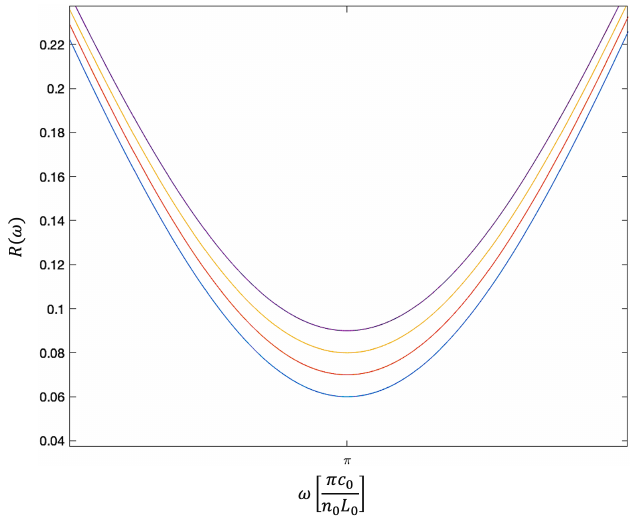
Figure 10. The dependence of the overall reflection rate R ( ω ) in Equation (37) of the Fabry-Pérot cavity in Figure 9 on the frequency ω of the incoming light. Here the mirror parameters are | r ( 2 ) | 2 = | r ( 2 ) | 2 = 0.81, while | r ( 3 ) | 2 = 0.1. In addition, P ( ≥ 1 ) equals 0.6 (blue), 0.7 (red), 0.8 a c c N (yellow) and 0.9 (purple). The graphs have again been calculated using Equations (23) and (32) and shows that the presence of a relatively large number of tiny, randomly-positioned mirrors increases the minimum of the reflection rate R ( ω ) of the Fabry-Pérot cavity. Instead of zero, the minimum now equals R min in Equation